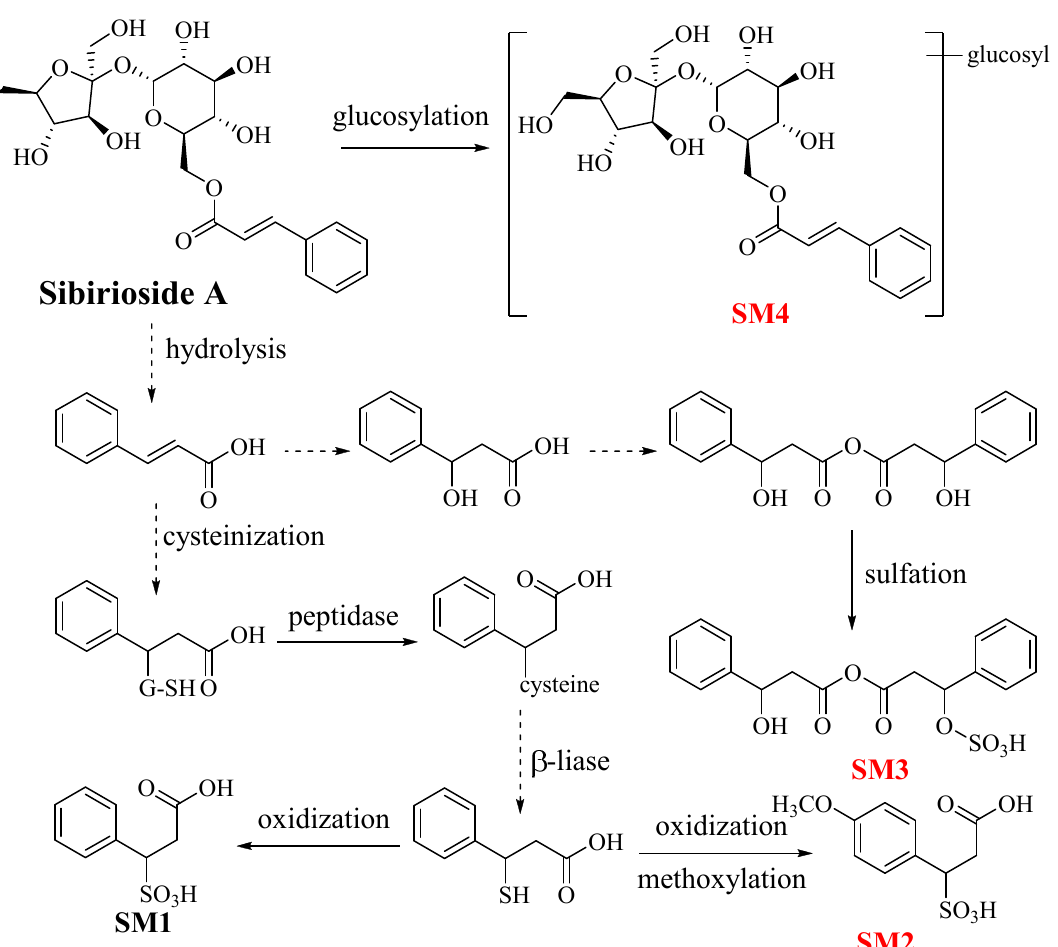
Figure 3. The metabolites and metabolic pathways of sibirioside A in rats.